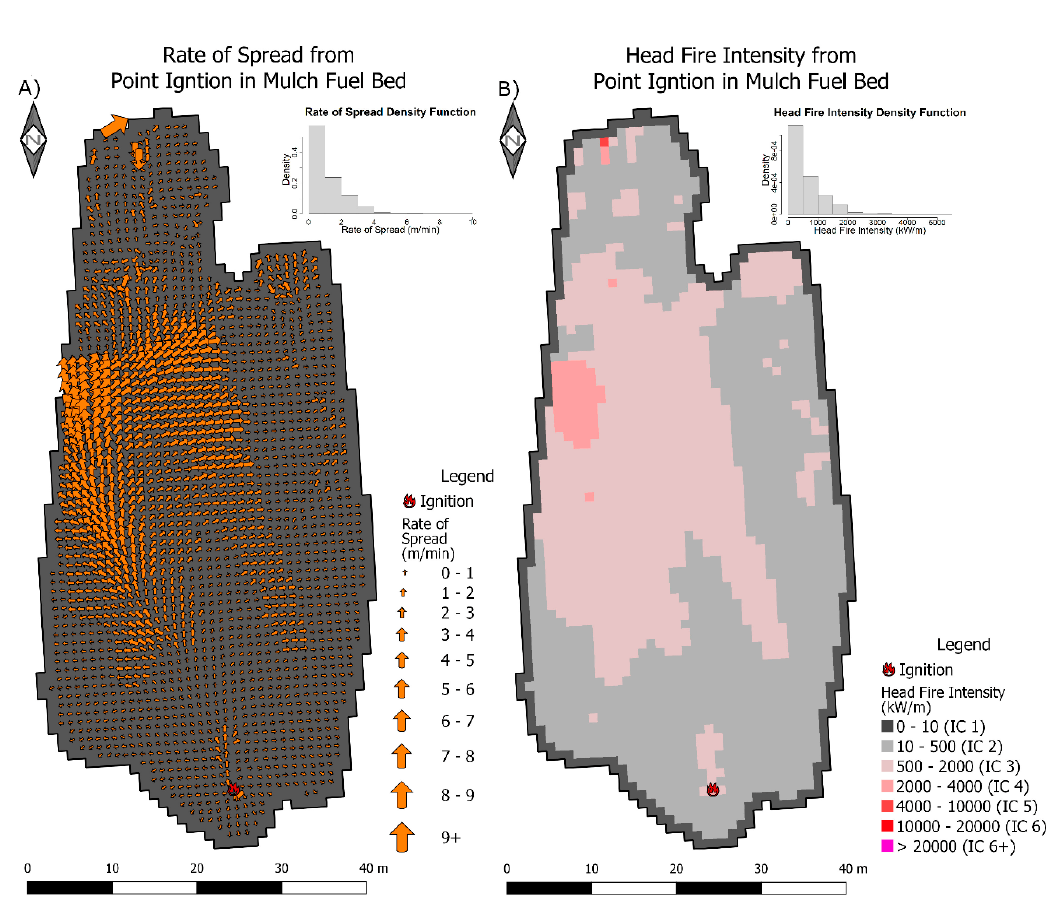
Figure 3. Maps of ( A ) rate of spread ( B ) head fire intensity with intensity class (IC). Head fire intensity used the average observed fuel consumption of 1.8 kg m − 2 .